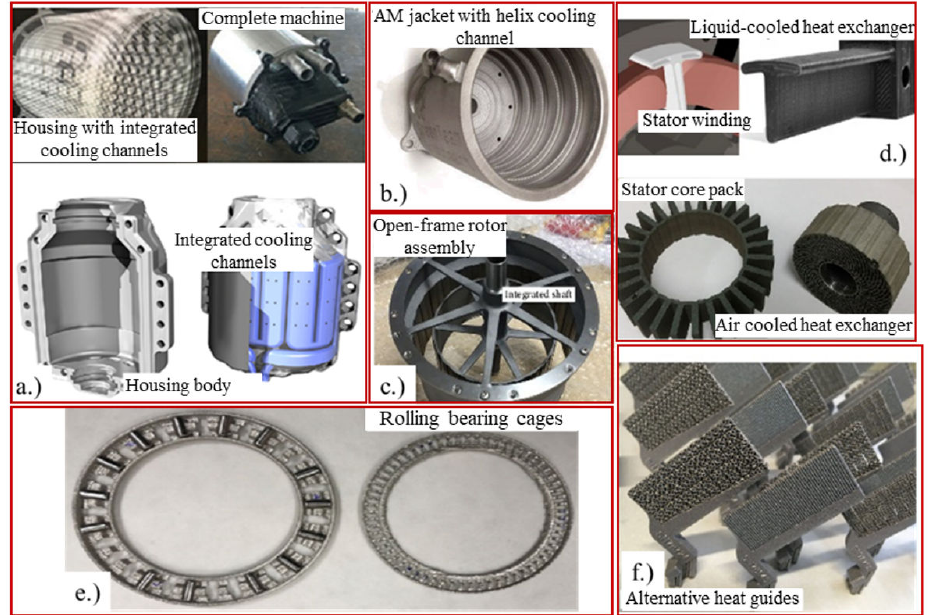
Figure 5. AM-built electrical machine parts ( a ) [60,61], ( b ) [65], ( d ) [62] integrated liquid cooled assemblies ( c ) air cooled rotor and stator assembly [66] ( e ) rolling bearing cages [63] ( f ) heat exchang- ers